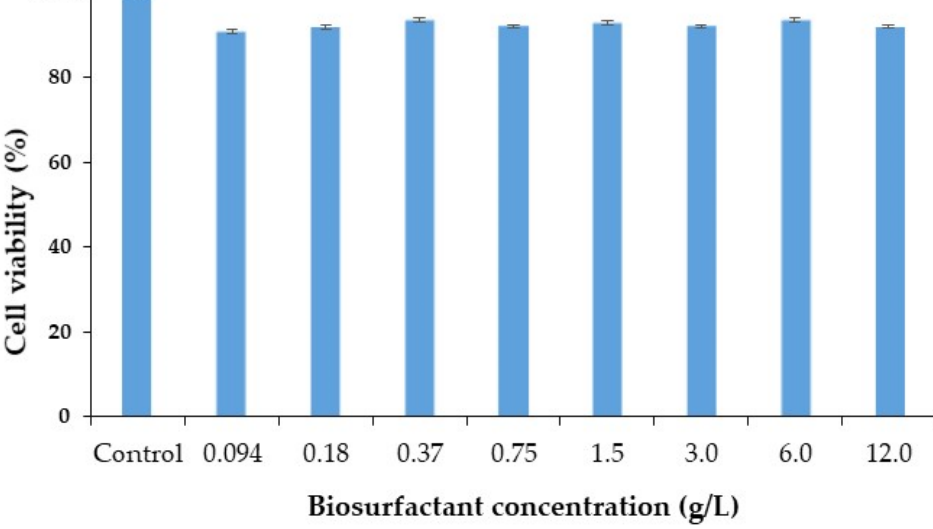
Figure 9. Percentage of mouse fibroblasts (L929) viability assessed with the MTT assay. A rhamnolipid produced by Pseudomonas aeruginosa showed toxicity at concentrations equal to or greater than 0.20 g/L in tests with the HepG2 cell line (human hepatoma) [28], while another one produced by Aspergillus niger showed no cytotoxic activity to mouse fibroblast cells (18.75% inhibition of growth) [29]. Ribeiro et al. [30] found that biosurfac- tants obtained from Saccharomyces cerevisiae and Candida utilis did not show cytotoxicity against the non-cancerous L929 and RAW 264.7 cell lines. Finally, Marqu é s et al. [31] reported lower toxicity of a biosurfactant produced by Rhodococcus sp. 51T7 compared to synthetic